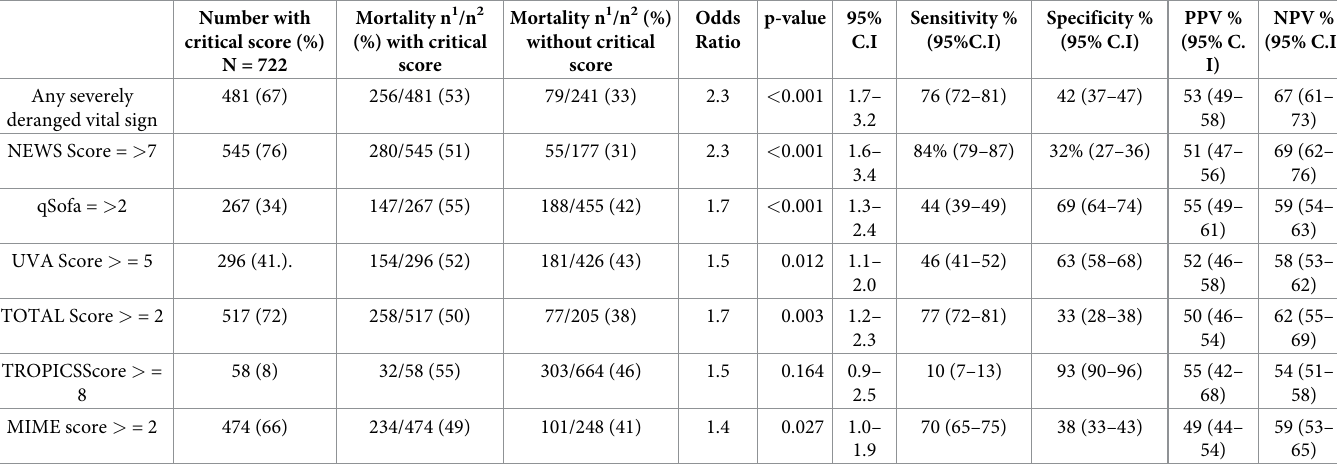
Table 3. Predictive values of severity score models for patients over 16 years.